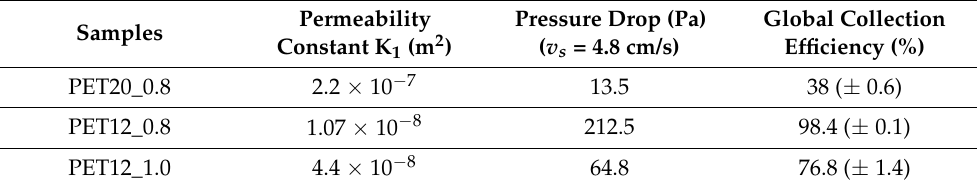
Table 3. Filtration performance of recycled PET microfiber filters.